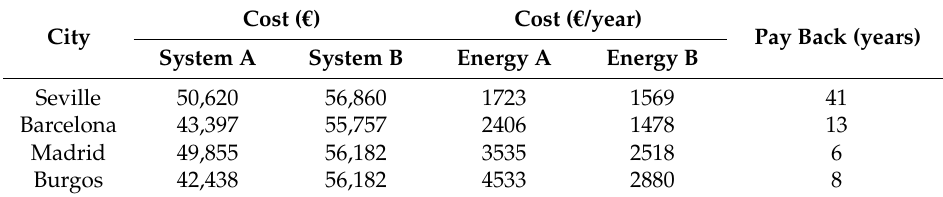
Table 9. Payback period of the investment in the aerothermal heat